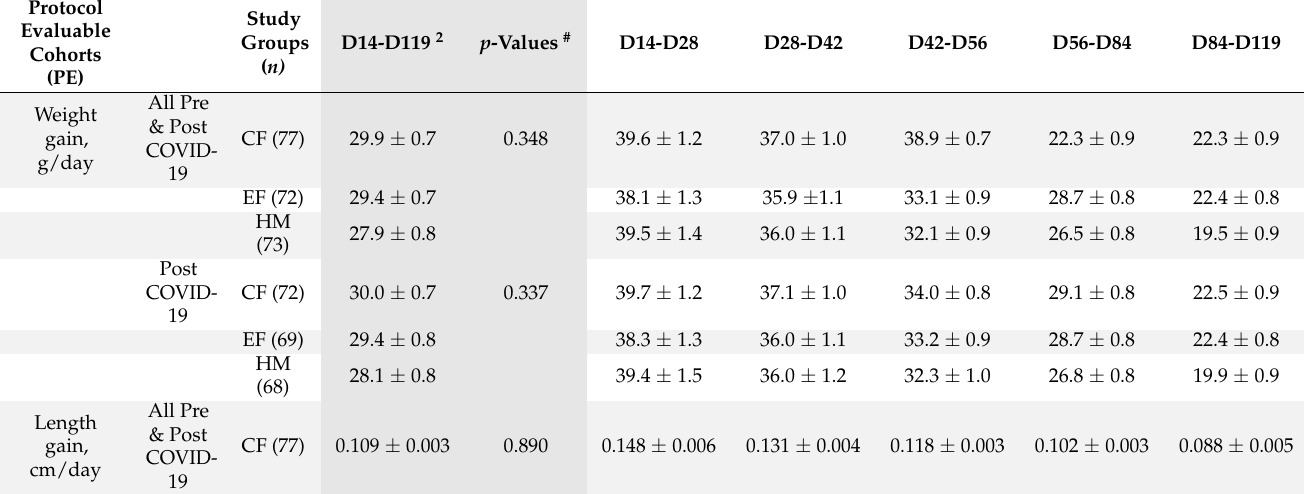
Table 2. Anthropometric Measures (Gompertz’ predicted) 1